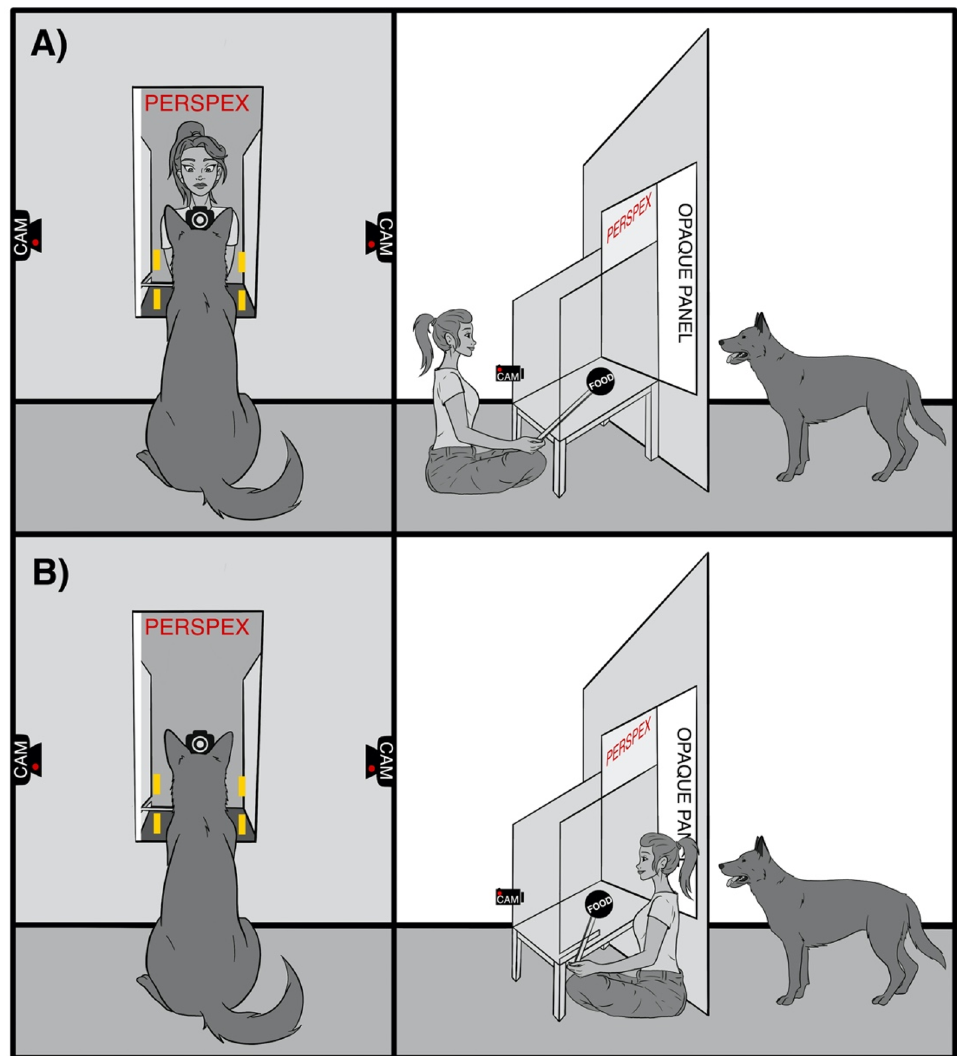
Figure 3. Experimental apparatus, ( A ) experimenter position during the frustration social condition, ( B ) experimenter position during the frustration non-social and positive anticipation